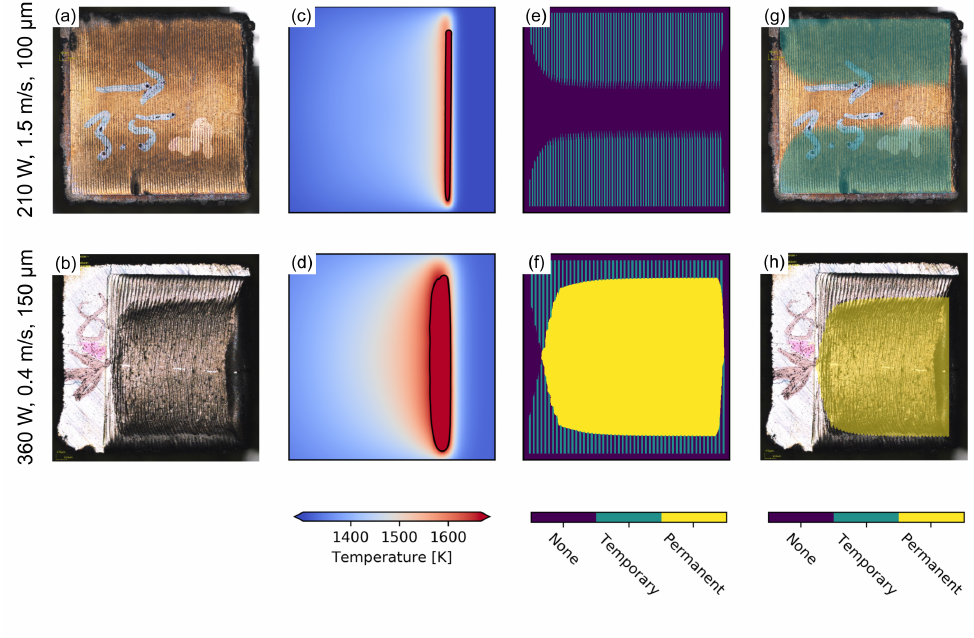
Figure 3. Experimentally observed surfaces ( a , b ) of single layer remelting experiments on CMSX-4 substrate with corresponding temperature fields ( c , d ) and calculated persistent regions ( e , f ). Super- position of simulation and experiment in ( g , h ). Lateral melt direction from left to